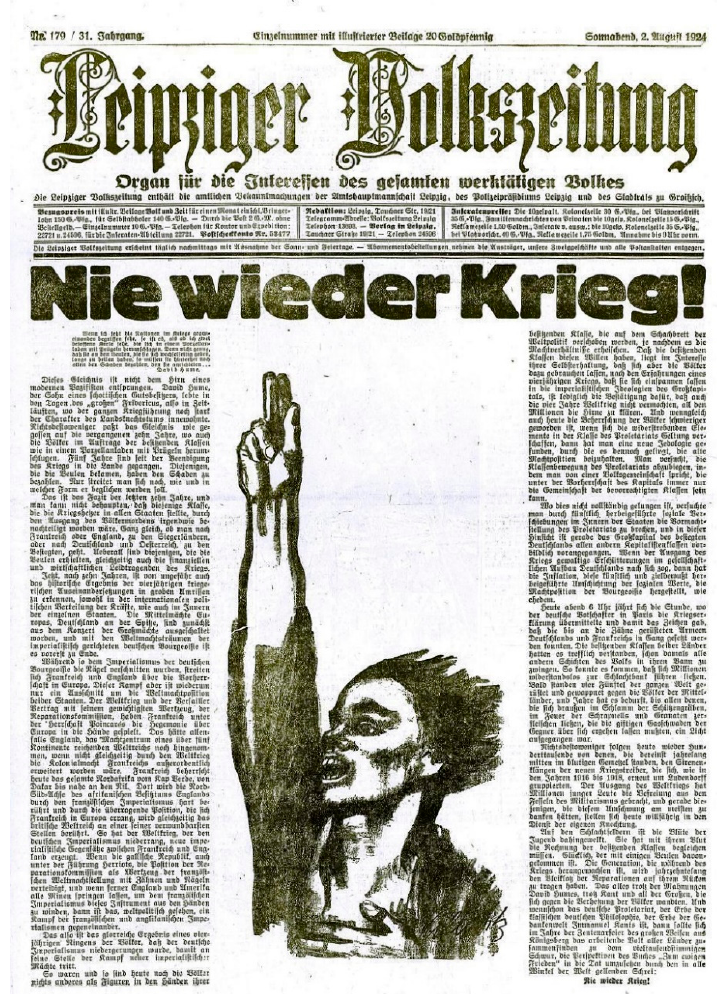
Figure 7. Front page of the Leipziger Volkszeitung , Saturday, 2 August 1924, with an illustration of Kollwitz’s No More War poster figure.